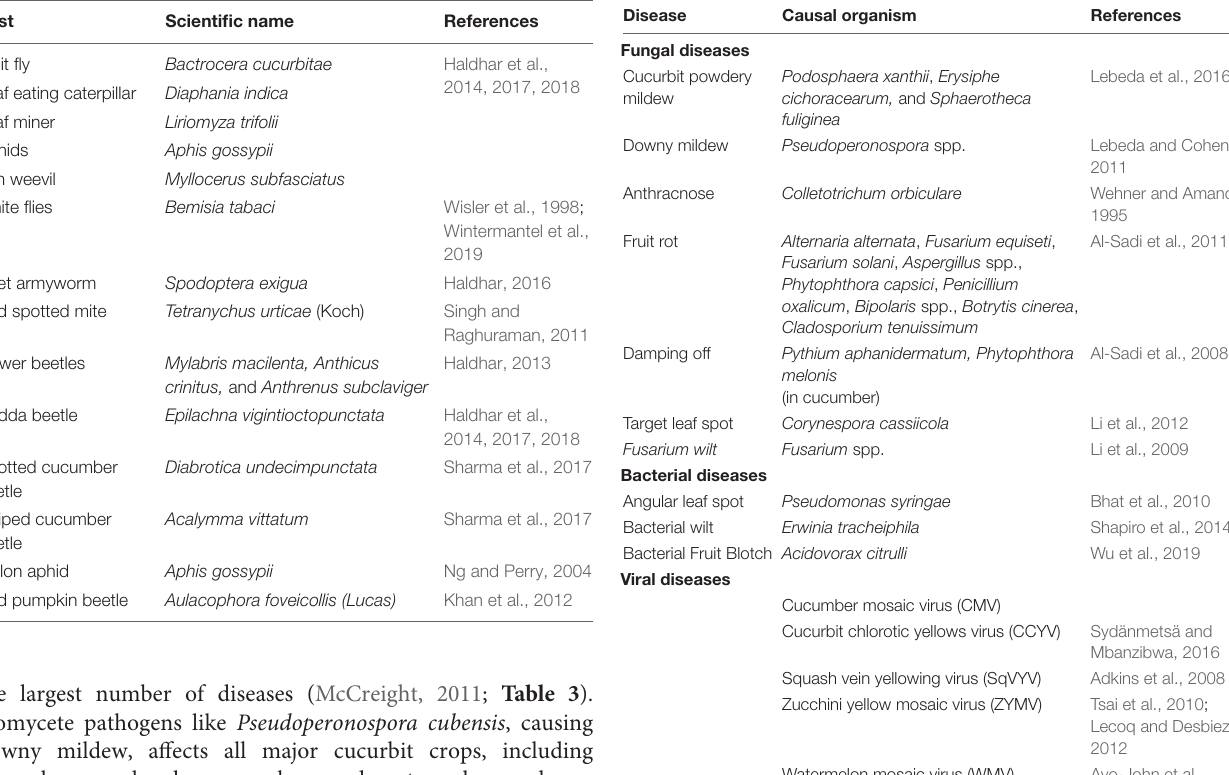
TABLE 2 | Major pests of